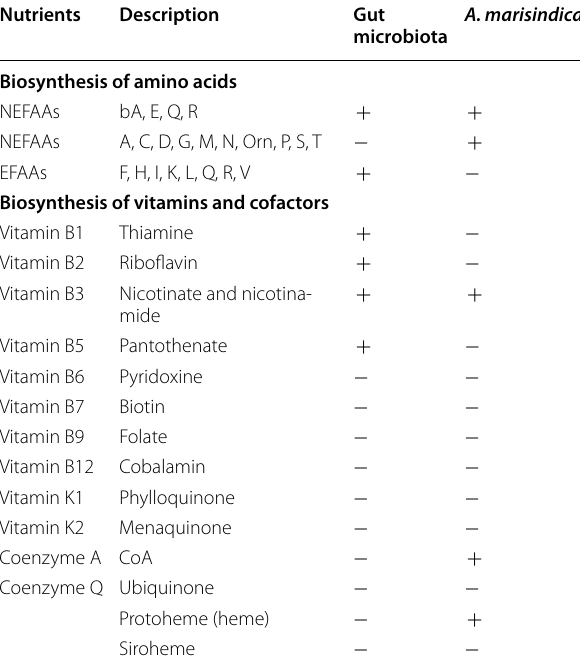
Table 1 Nutrient biosynthesis capability of gut microbiomes of Alviniconcha marisindica from Wocan site, showing the nutrients with and without complete biosynthesis pathways in the metagenomes of gut microbiomes